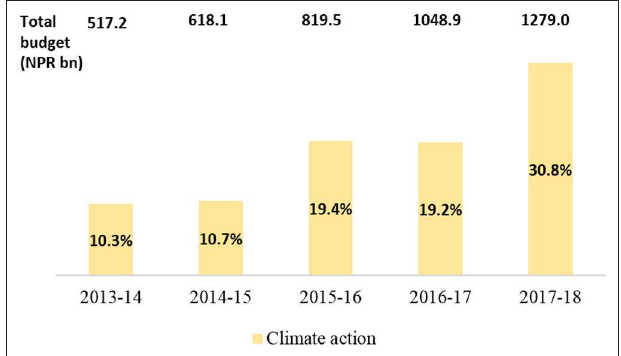
FIGURE 4 | Share of national budget allocation toward climate change action